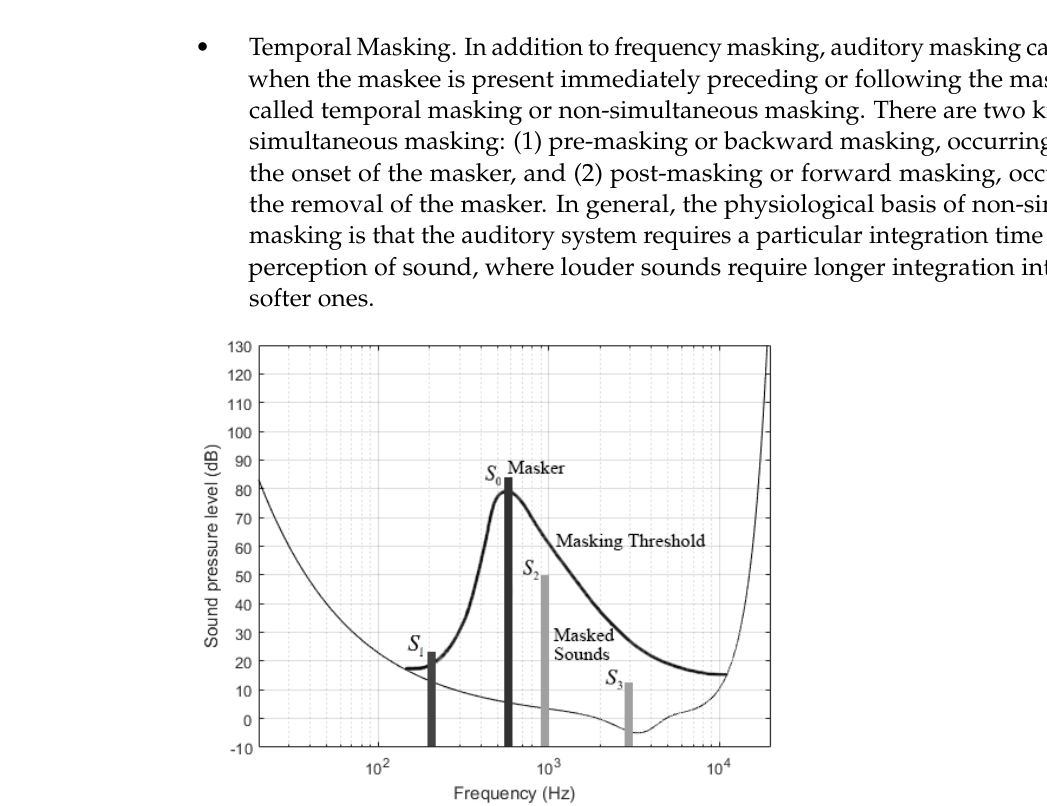
Figure 2. The masking effect of a pure tone with a 500 Hz loudness of 80 dB in the presence of other pure tones, and this picture is cited from